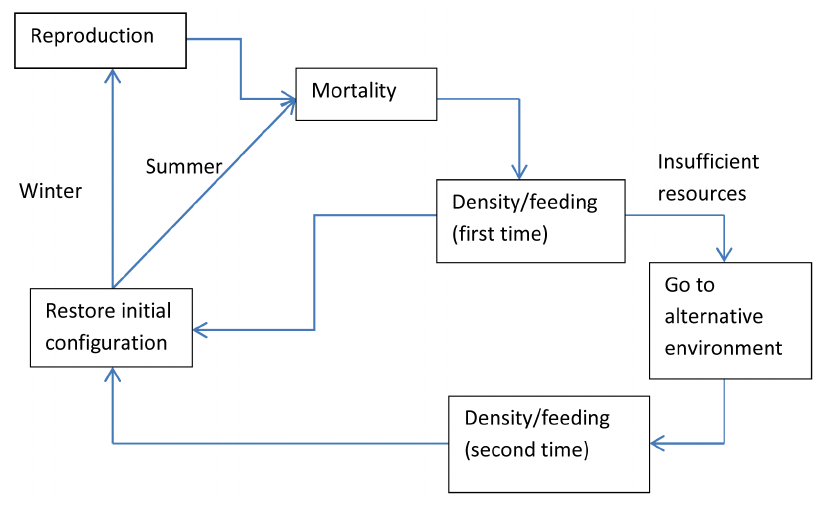
Figure 8. Scheme proposed for the model by Margalida & Colomer (2012).